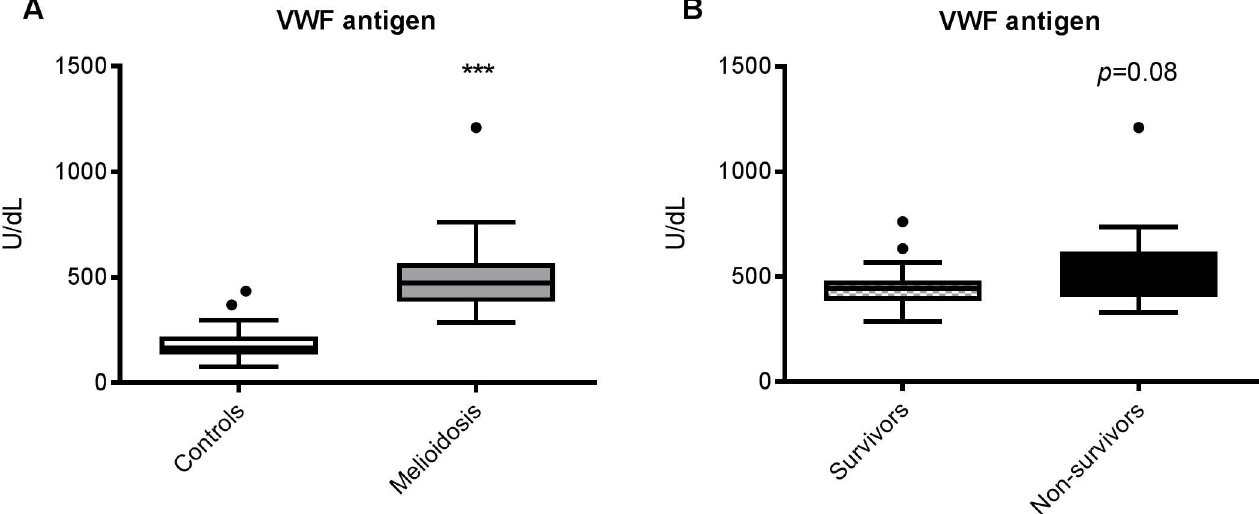
Fig 2. VWF antigen levels are also elevated in melioidosis (A), but do not correlate with mortality (B). VWF = von Willebrand factor. The data from 34 melioidosis patients (of whom 12 died) and 52 controls are presented as box plots with Tukey whiskers showingthe smallest observation, lower quartile,median, upper quartileand largest observation. *** P < 0.001for the difference betweenpatients and controls; P = 0.08 for the difference betweensurvivors (n = 22) and non-survivors (n = 12) (Student’s